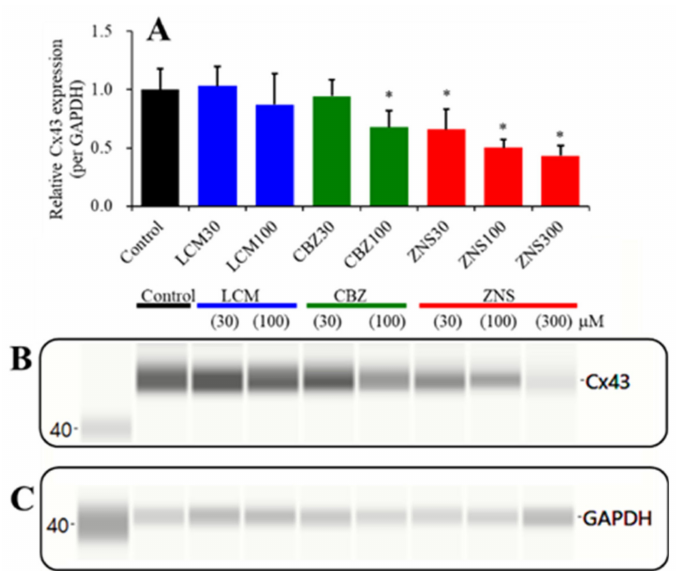
Figure 6. Concentration-dependent e ff ects of the subchronic administration of LCM (30 or 100 µ